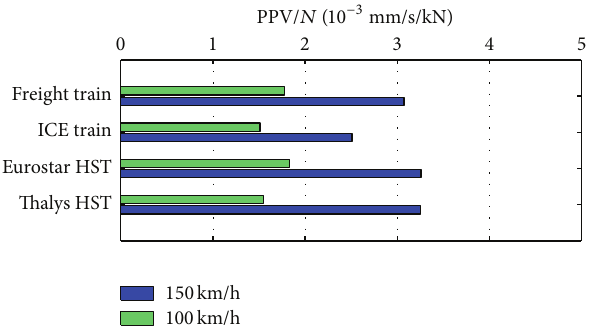
Figure 13: Influence of the vehicle speed and the vehicle type on the PPV /𝑁 indicators at 10 m from the